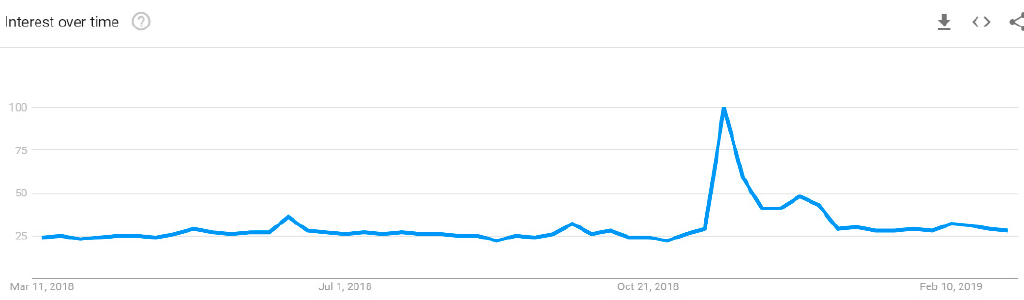
Figure 5. Google Trends for “Dolce & Gabbana” over the past 12 months. (Data Source: Google Trends, 12 March 2019).